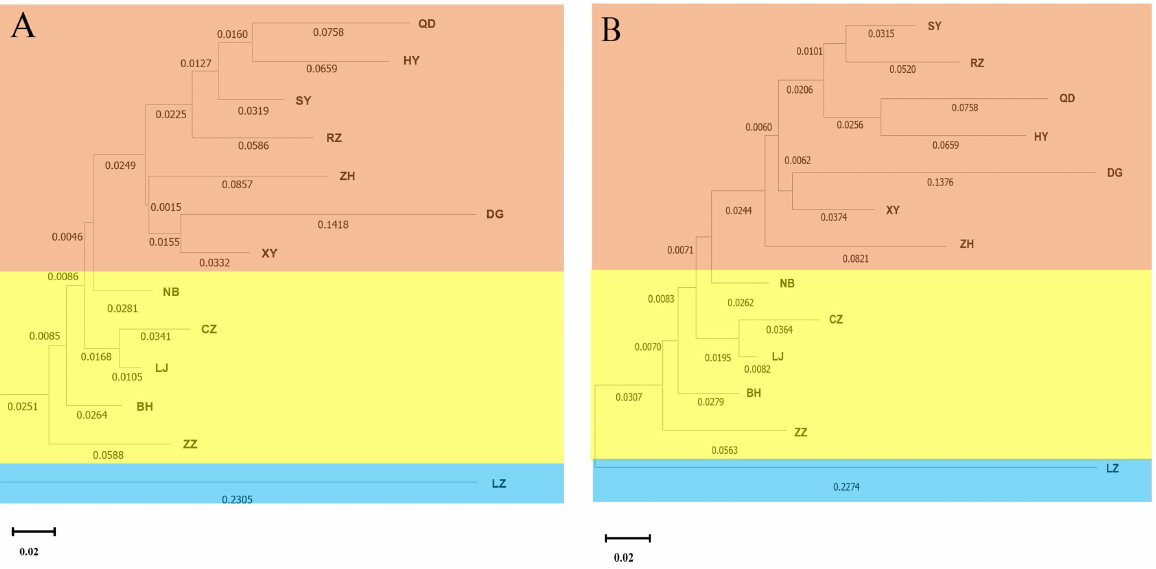
Figure 2. Cluster analysis of 13 populations of R. philippinarum by NJ (the neighbor-joining) and ME (the minimum evolution) methods. ( A ) NJ tree; ( B ) ME tree. The different colors are used to differentiate the clustered clades among the clam populations. The orange color represents the independent branch of the clam populations, including QD, HY, SY, RZ, ZH, DG, and XY. The orange clade clusters with the yellow branches (NB, CZ, LJ, BH, and ZZ), forming into a higher-level clade. The blue color represents the independent branch for the LZ population different from the large clade. For each locus, the F st value was ranging from 0.0357 to 0.1729 ( p < 0.01), with an average of 0.0663 (Table S2). The N m value of gene flow was varying from 1.1958 to 6.6869, with an average of 4.5900. The F is value for each locus was calculated to be ranging from − 0.1021 to 0.6411, with an average of 0.1855. The STRUCTURE analysis revealed K = 3 was the most probable number of populations to explain the observed genotypes (Figure 3). As indicated by STRUCTURE analysis, all the individuals can be divided into three sub- groups (Blue, Green, and Red; Figure 3). Consistently, the individuals from each population were also classified into the three genetic clusters, suggesting the high gene flow of these clam populations. According to AMOVA analysis, the greatest number of variances occurred within individuals (67.33%), compared to 25.7% among individuals and 6.97% among the populations (Table 4).